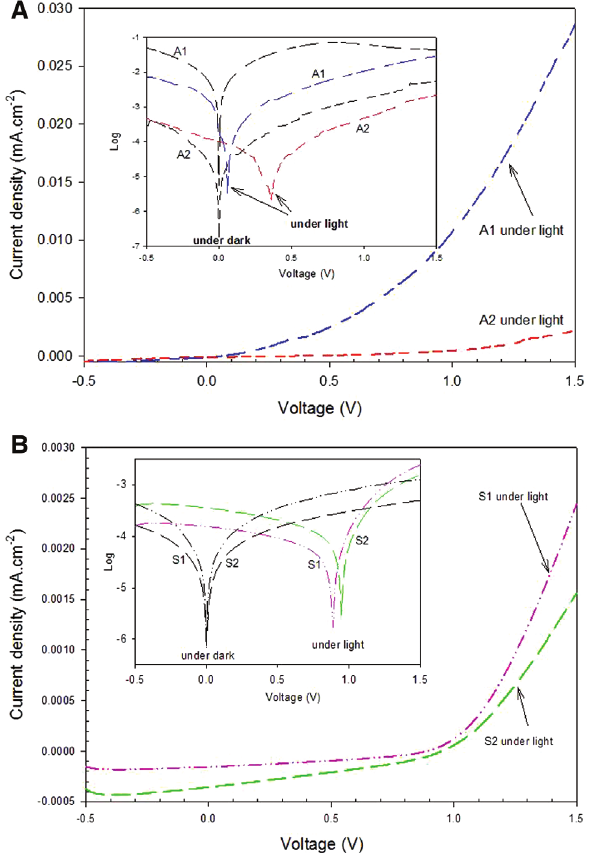
Figure 13 I-V Characterization under light illumination (1.5 AM) of BHJSC devices with the active layer blends (A) A1 and A2, and (B) S1 and S2. The insets are their corresponding log I–V properties in the dark and under light illumination.